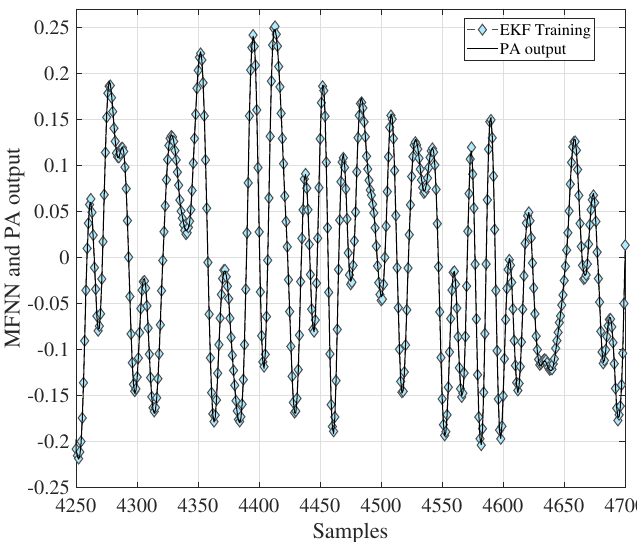
Figure 17. Comparison of results obtained between MFNN based on EKF training and PA